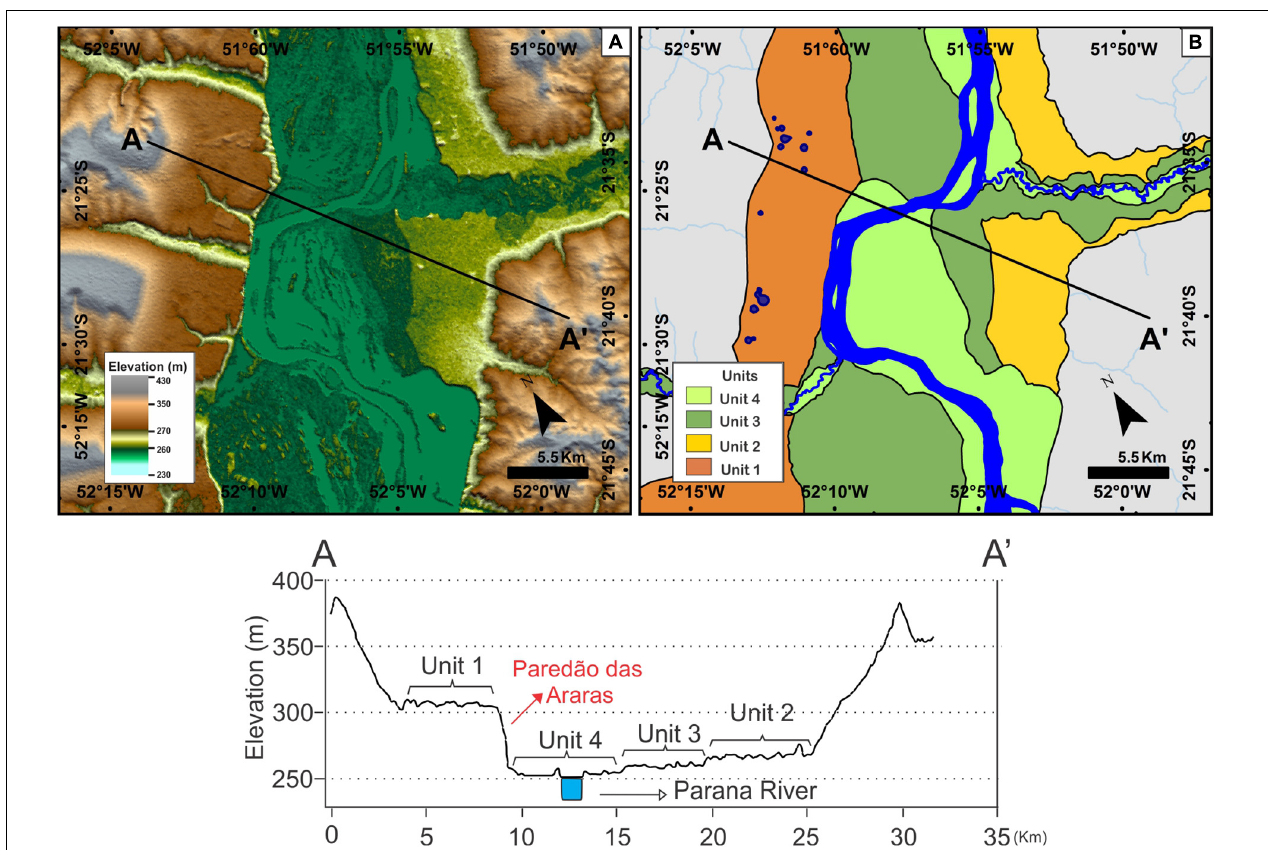
FIGURE 3 | Representative terrace levels and fluvial plain mapped in the Upper Paraná River. (A) Digital Elevation Model (DEM) elaborated from SRTM data; (B) Geomorphologic units: Unit 1 in brown, Unit 2 in yellow, Unit 3 in dark green and Unit 4 in light green. Topographic profile below A-A (cid:48) , with altimetric levels of approximately 300 m for Unit 1, 270 m for Unit 2, 260 m for Unit 3, and 250 m for Unit